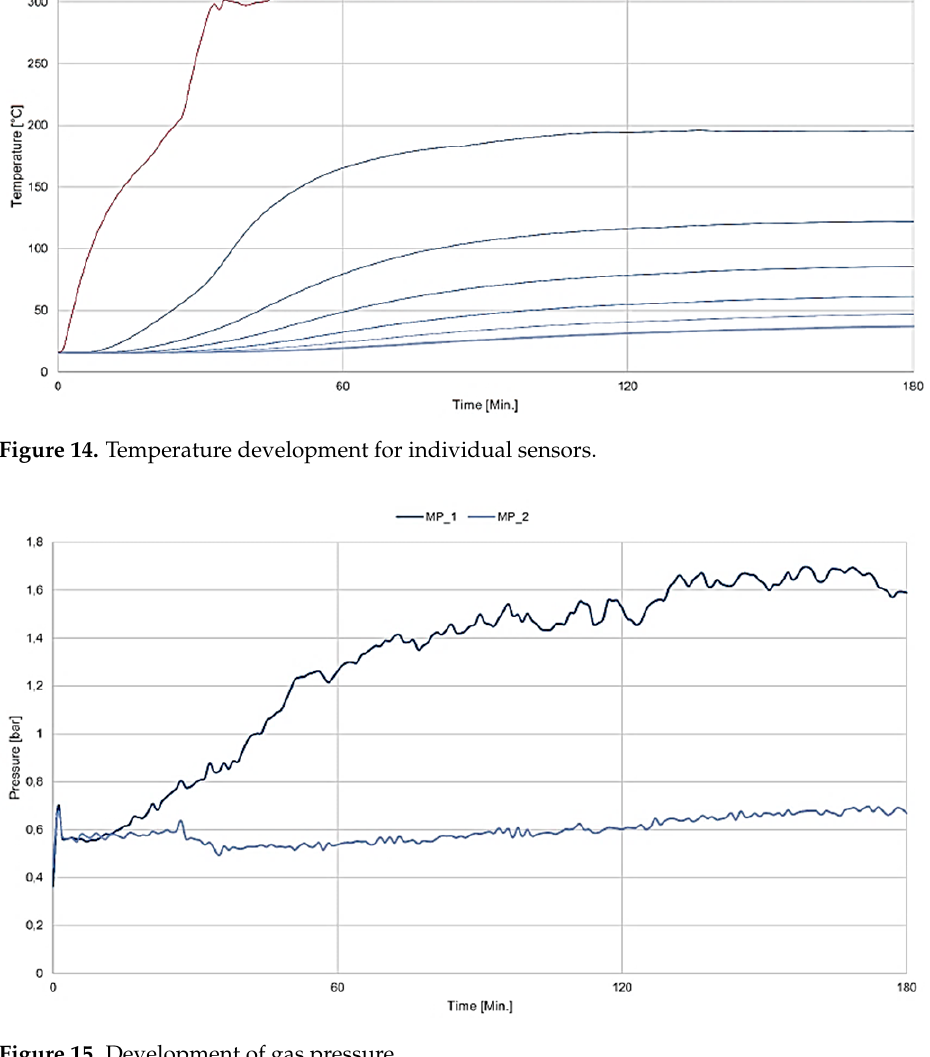
Figure 15. Development of gas pressure.